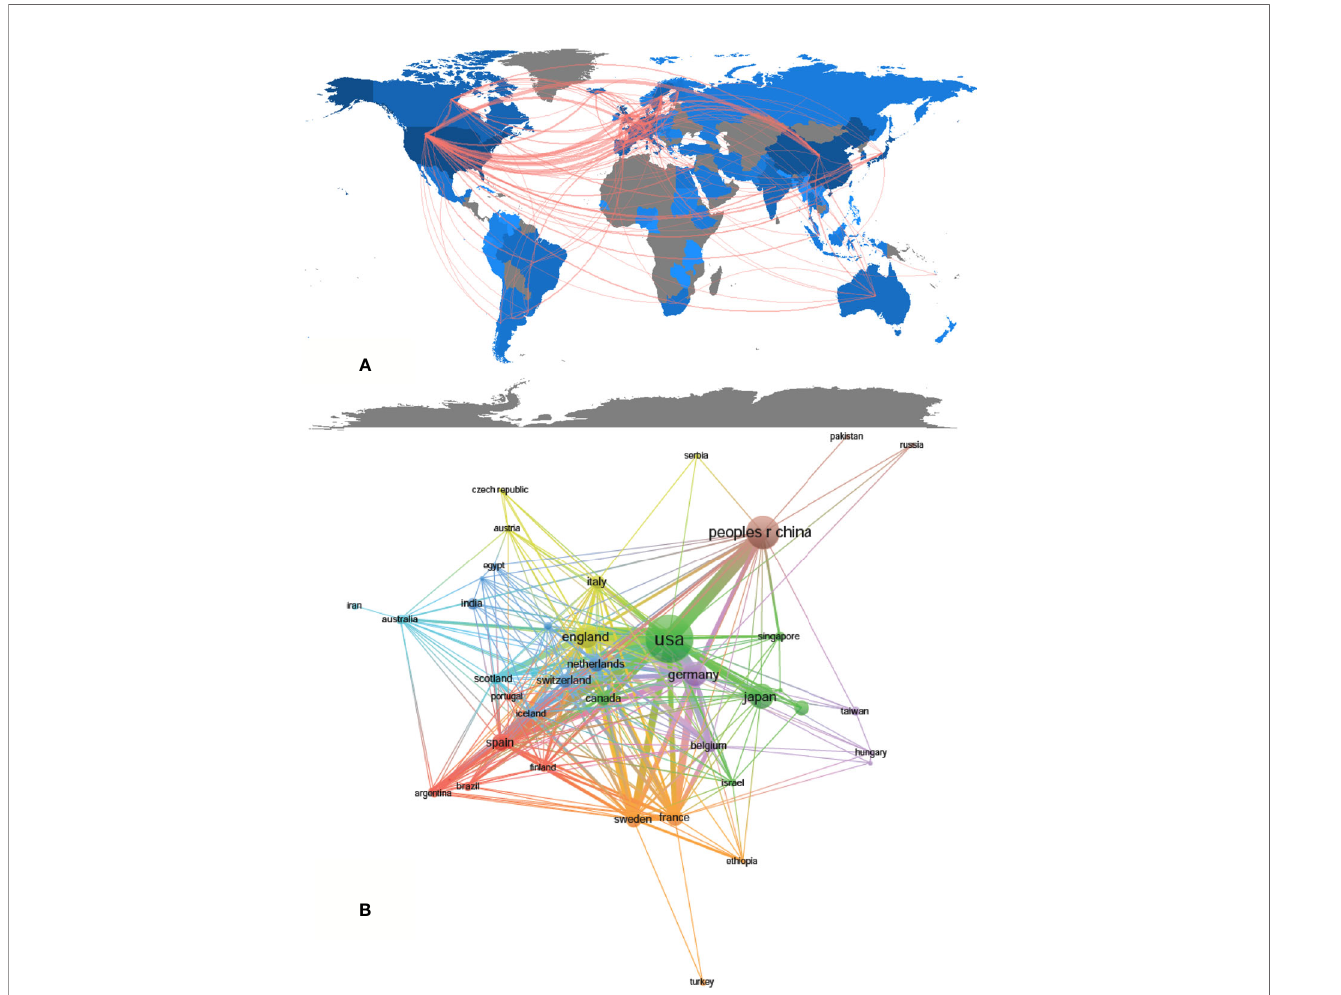
FIGURE 2 | The regional distribution (A) and the network map of countries ( B , T = 5) related to drug-induced liver injury (DILI)